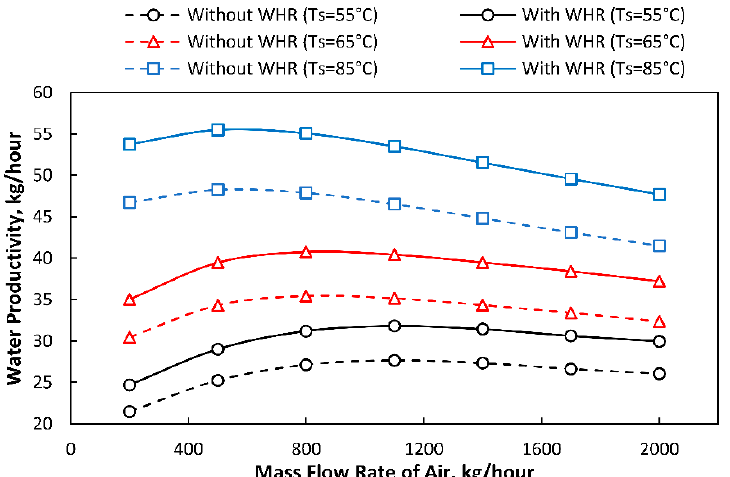
Figure 7. Effect of MFR of air on freshwater productivity with and without waste heat recovery.